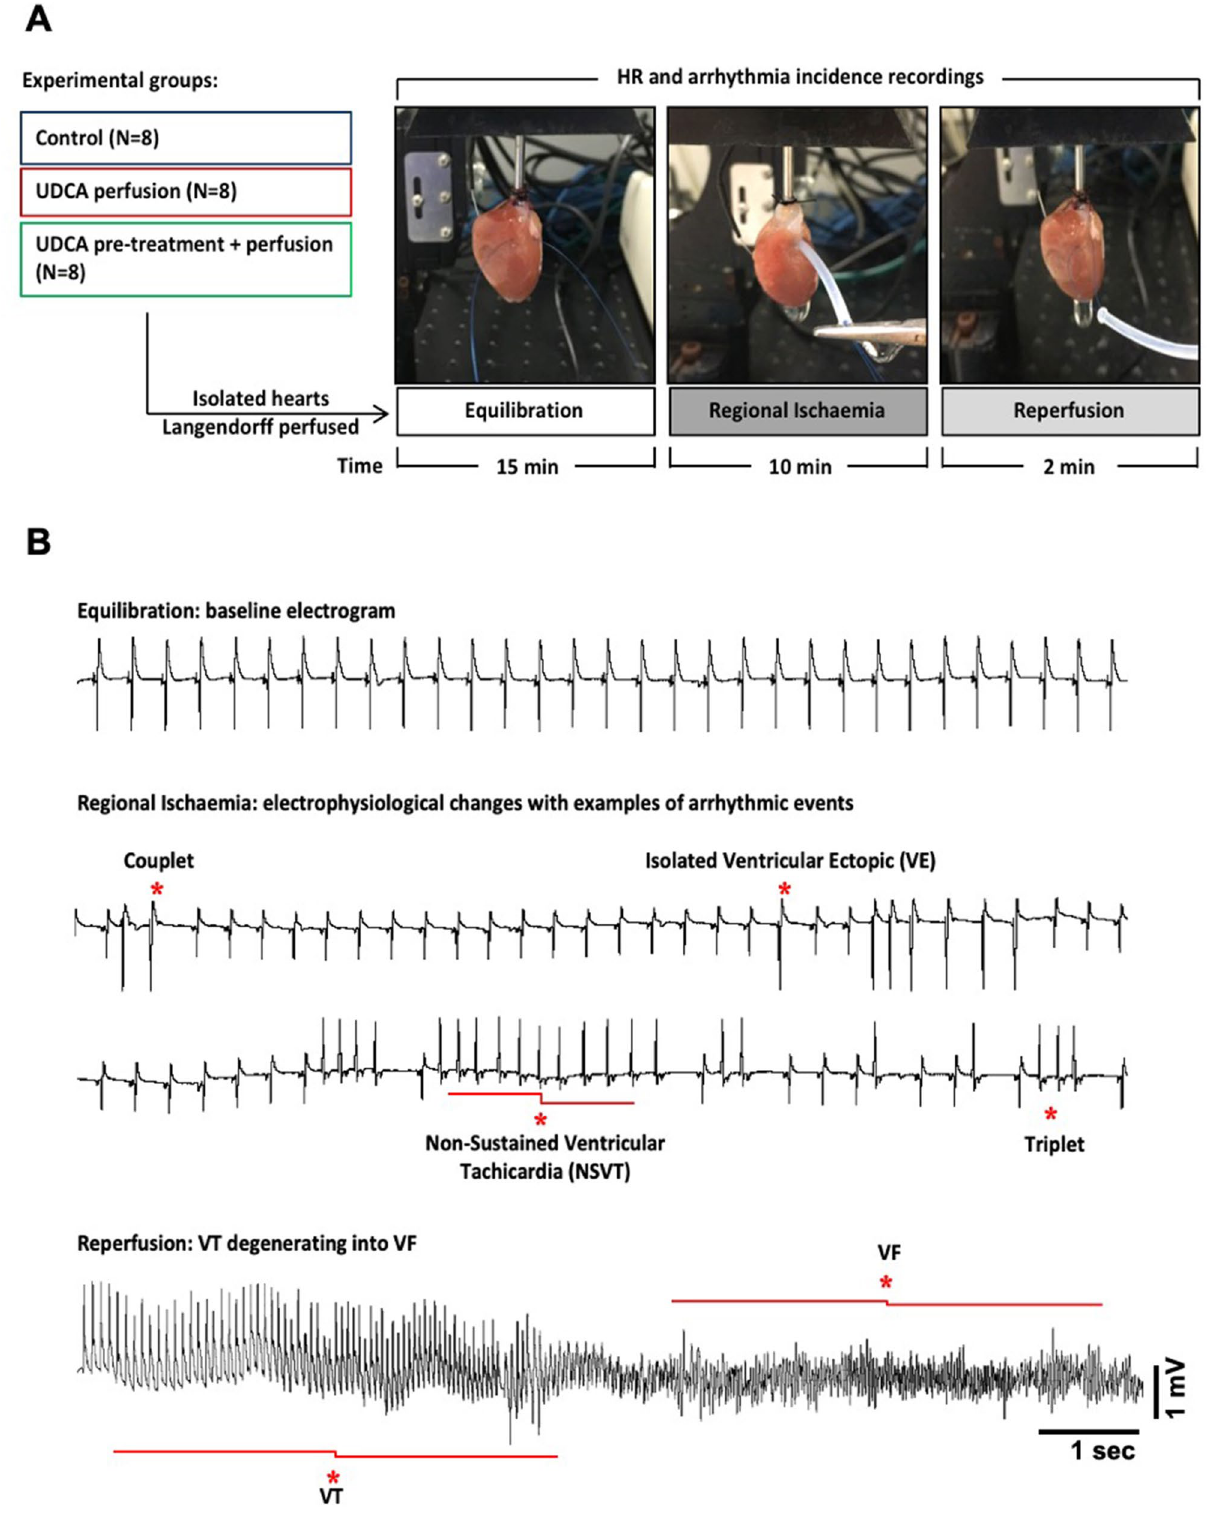
Figure 1. ( A ) Schematic experimental protocol of isolated rat hearts exposed to acute regional ischaemia for 10 min, followed by 2 min reperfusion. ( B ) Electrocardiogram recordings taken from the same heart showing marked electrophysiological changes and examples of ventricular arrhythmias occurred during the course of acute ischaemia in the form of isolated premature ventricular ectopic (VE), couplet, triplet and non-sustained ventricular tachycardia (NSVT), which result in ventricular tachycardia (VT), degenerating into ventricular fibrillation (VF) during